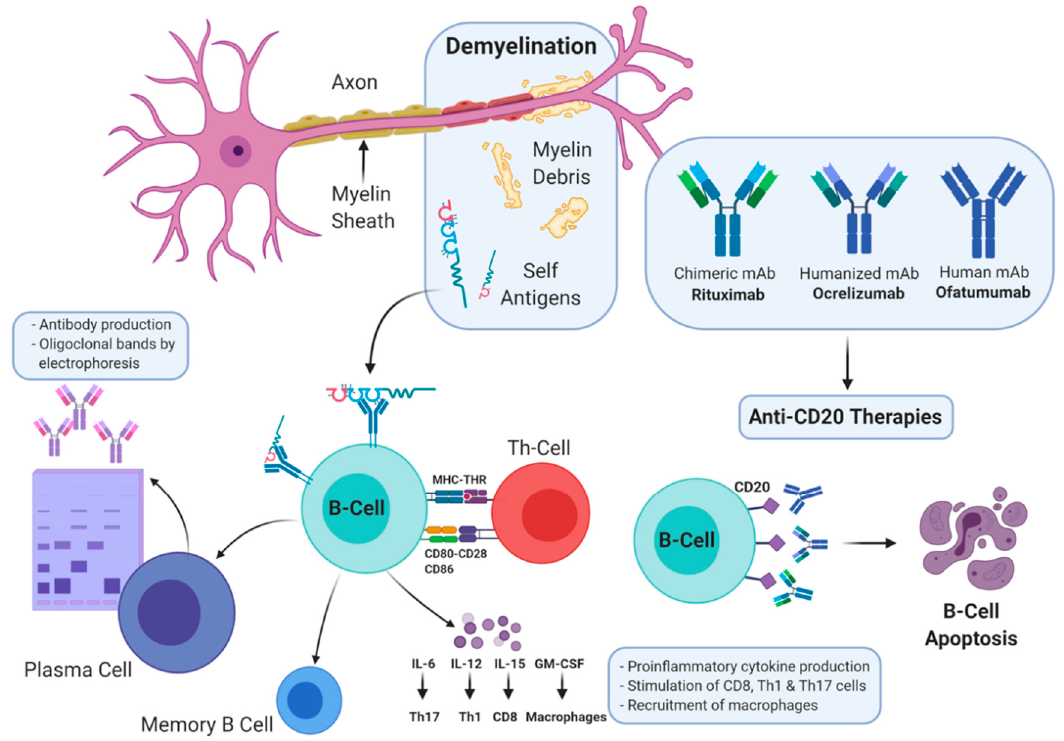
Figure 1. Three Anti-CD20 Antibodies: Rituximab, Ocrelizumab, and Ofatumumab. mAb: monoclonal antibody, Th: T-Helper, IL: Interleukin.